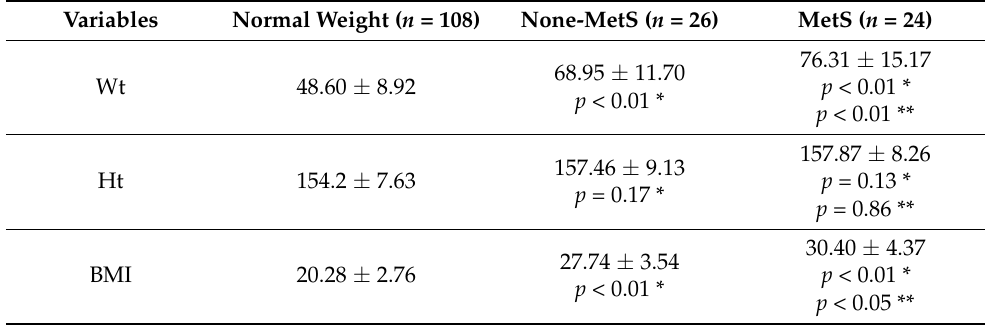
Table 1. Anthropometric measurements, BIA, and biochemical data stratified by study group (normal weight, None-MetS,